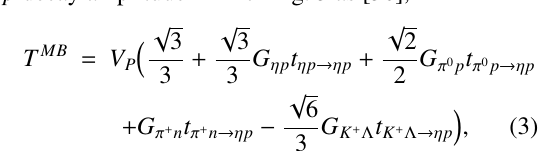
→ ¯ K 0 η p decay: (a) direct ¯ K 0 η p c